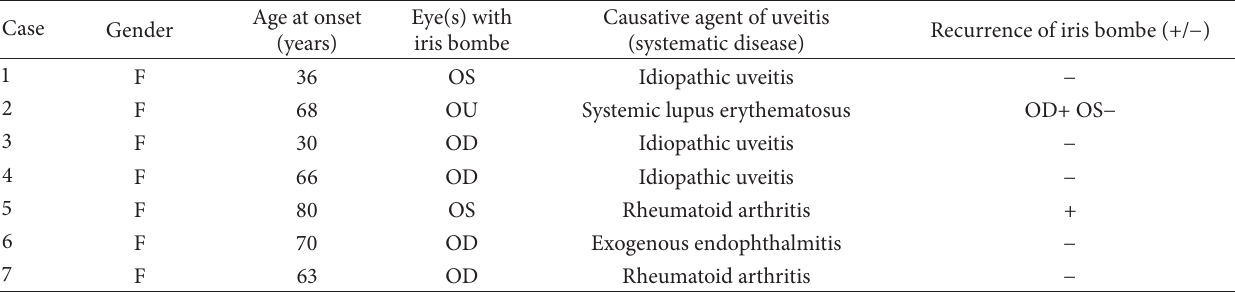
Table 1: Summary of data on seven patients with iris